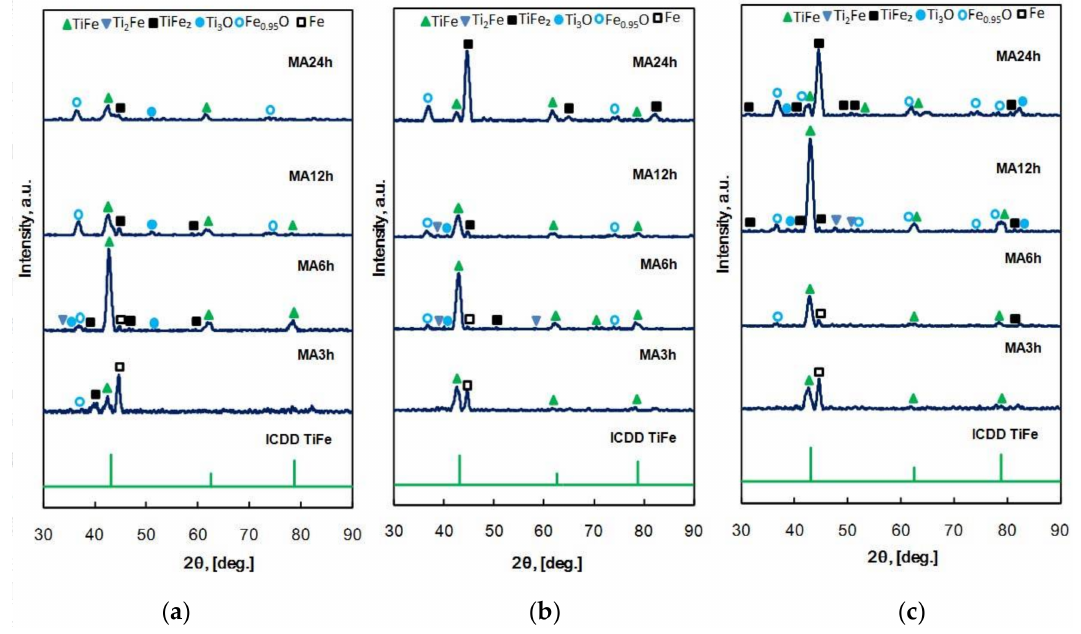
Figure 2. XRD patterns of MA samples with different Ti-contents and milling time. ( a ) 60 at % Ti-Fe; ( b ) 55 at % Ti-Fe; ( c ) 50 at %